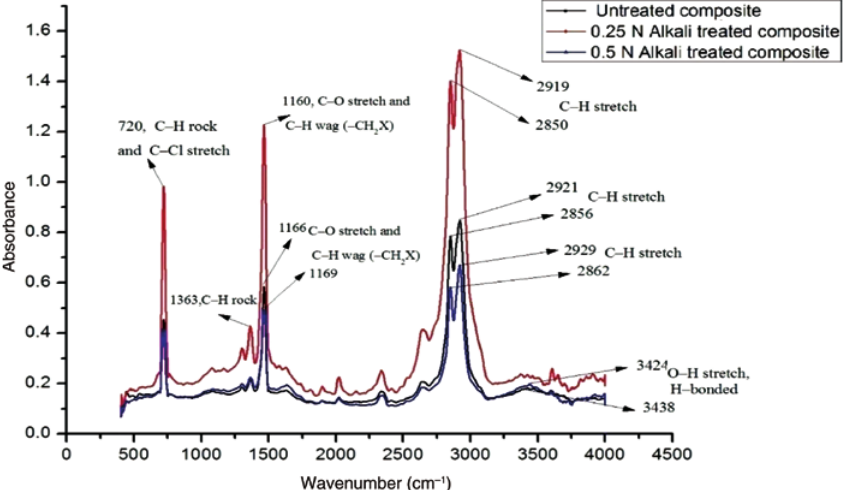
Figure 1: FTIR spectra of the untreated and AT composites.